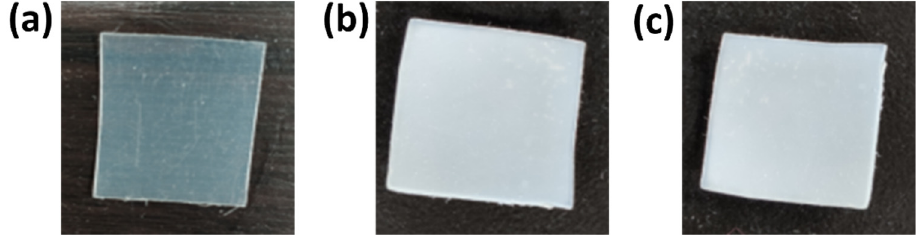
Figure 7. Photographs of the samples before and after the treatment: ( a ) original PP sheet, ( b ) the AAm ‐ grafted PP sheet PP ‐ g ‐ PAAm (101%), and ( c ) PP ‐ g ‐ P (AAm ‐ co ‐ AN) (23% AN).